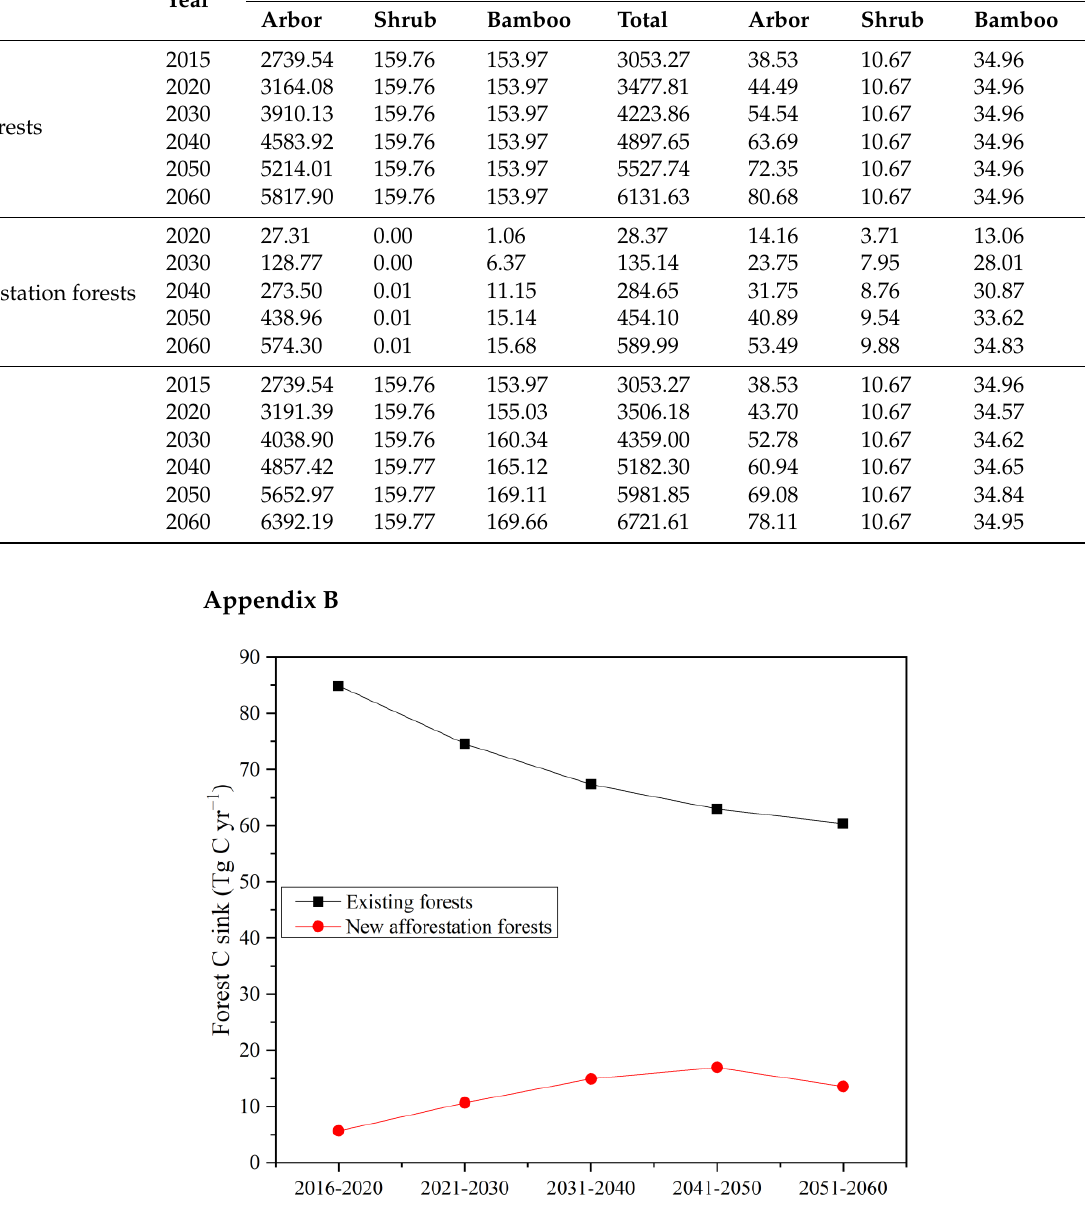
Figure A1. Variations in C sink in existing forests and new afforestation forests from 2016 to 2060 in the YREB.